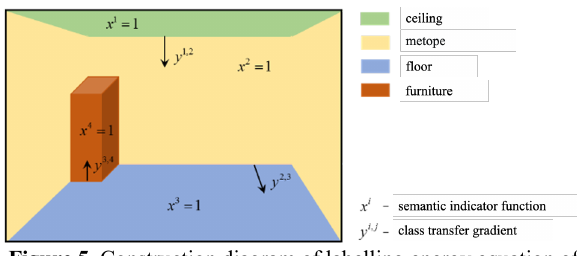
Figure 5. Construction diagram of labelling energy equation of multi-class voxel model.